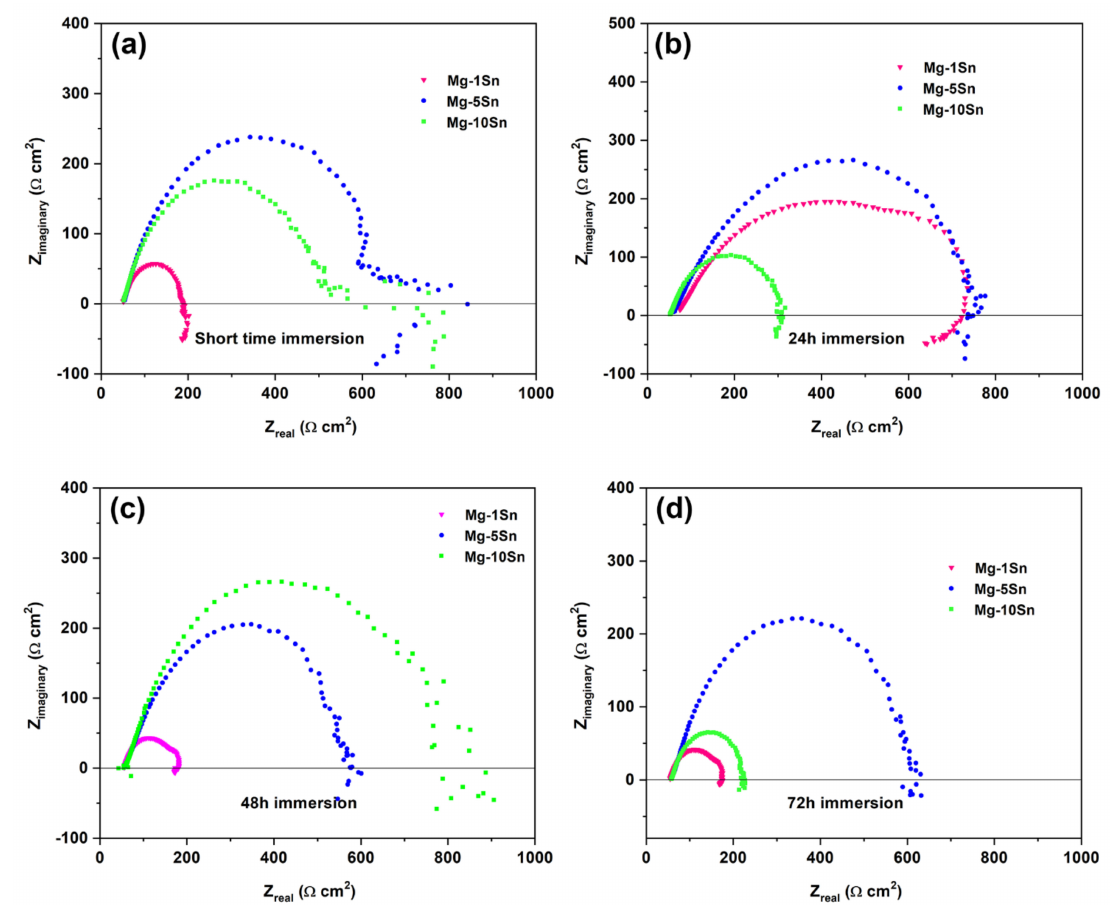
Figure 6. Nyquist curves obtained from EIS test on Mg-Sn alloys for different immersion period ( a ) Short term ( b ) 24 h ( c ) 48 h ( d ) 72